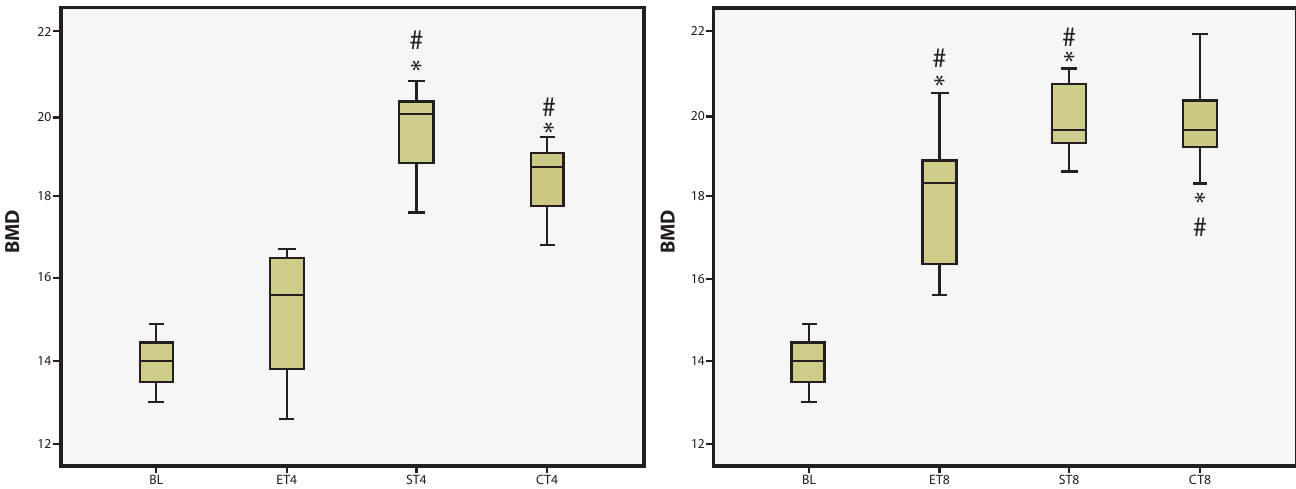
Figure 4: Box-plot with the values of BMD (g/cm²). * Significant difference in relation to the BL group; # Significant difference in relation to the ET4